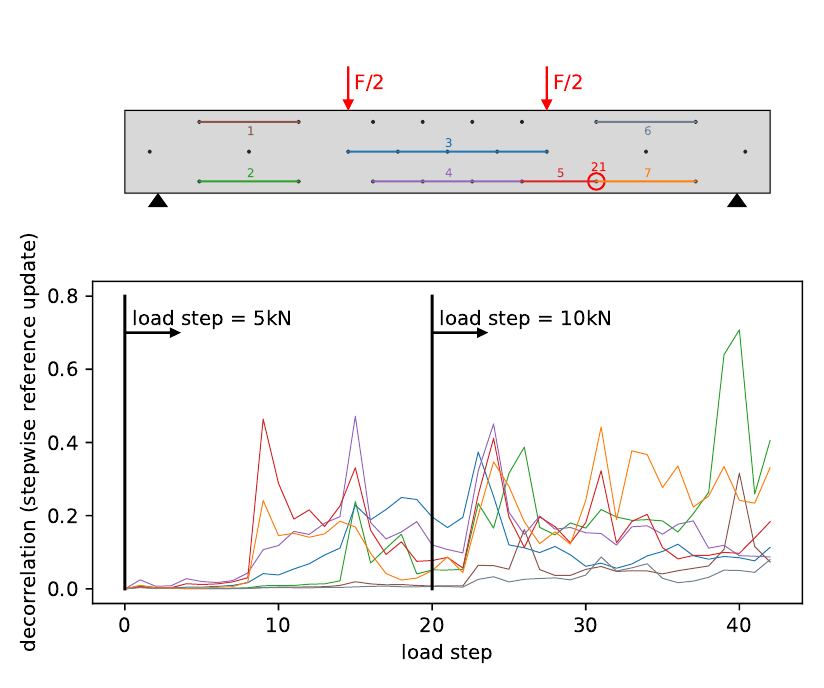
Figure 5. Decorrelation development on selected